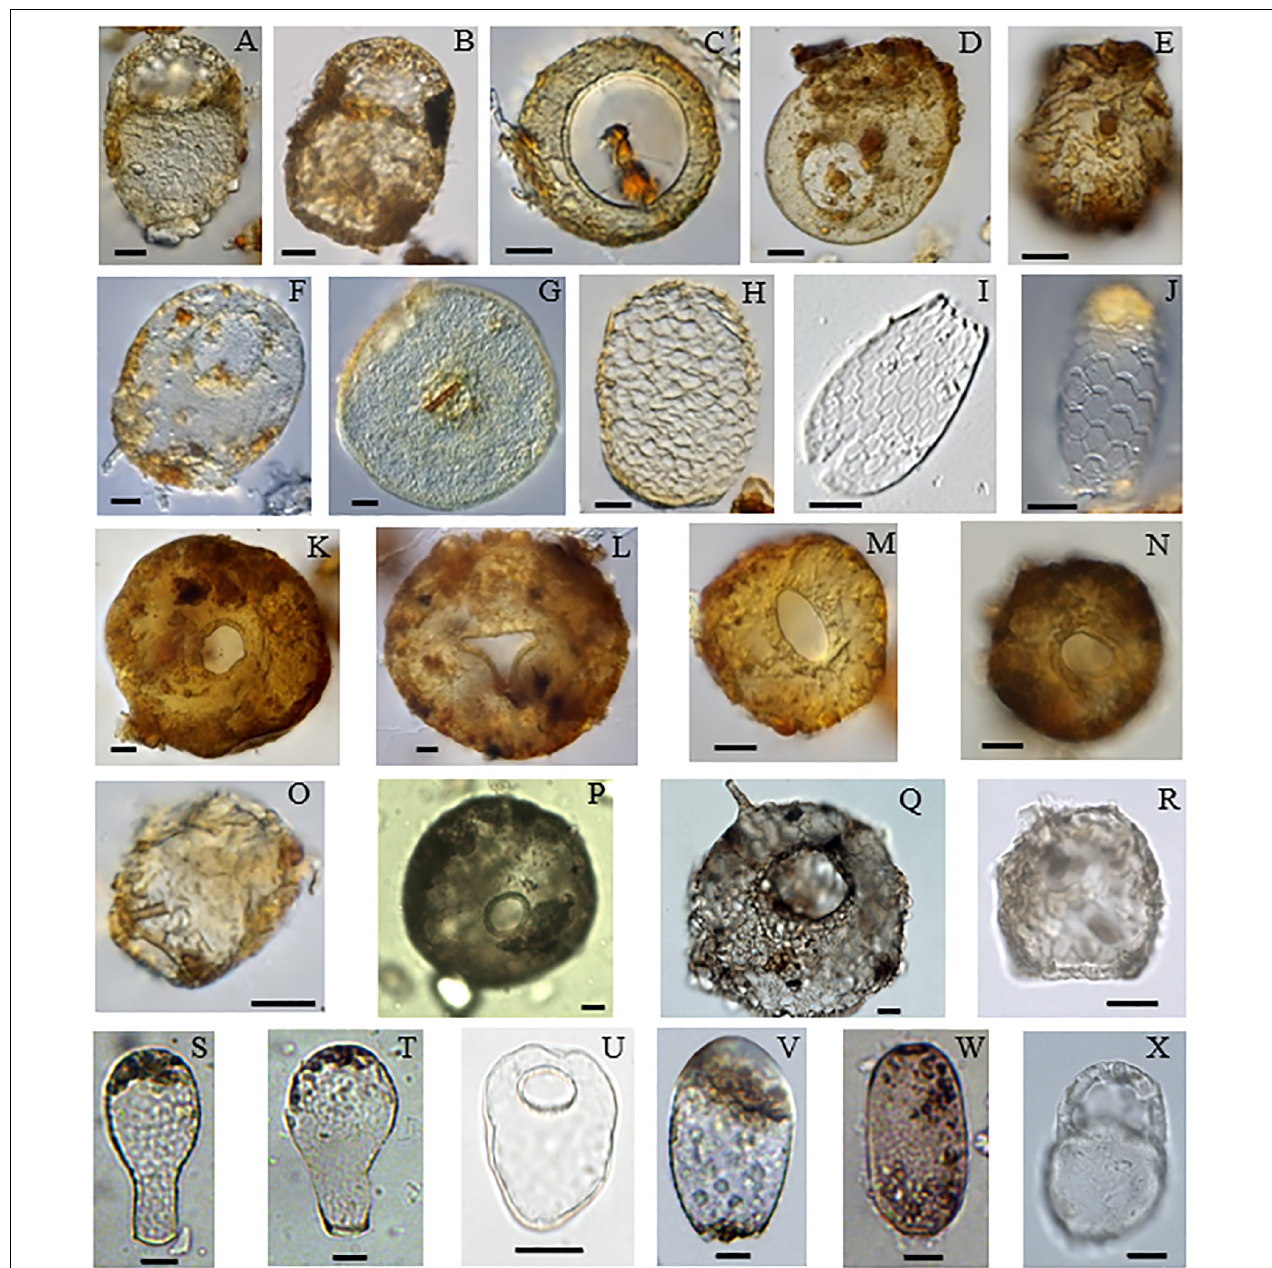
FIGURE 6 | Some taxa found in the samples. (A) Centropyxis constricta , (B) Centropyxis aerophila morph 1, (C) cf. Cyclopyxis eurystoma v. parvula morph 2, (D) Centropyxis aculeata oblonga morph 2, (E) Difflugia penardi morph 1, (F) Centropyxis aculeata oblonga morph 1, (G) Arcella arenaria v. compressa , (H) Heleopera sylvatica , (I) Euglypha rotunda , (J) Tracheleuglypha dentata morph 2, (K) Trigonopyxis sp1 morph 3, (L) Trigonopyxis arcula v. major , (M) Cyclopyxis sp1 morph 1, (N) Cyclopyxis sp1 morph 2, (O) cf. Cyclopyxis eurystoma f. alta , (P) cf. Trigonopyxis microstoma morph 1, (Q) Centropyxis aculeata morph 2, (R) Difflugia angulostoma , (S) Padaungiella tubulata morph 1, (T) Padaungiella wailesi morph 1, (U) Trinema complanatum morph 2, (V) Jungia sundanensis cf. ovoidalis , (W) Archerella flavum , and (X) Centropyxis platistoma morph 2. For taxa details, see Supplementary Table 2 . Scale bares = 10 µ m. Image A-O by F. Siemensma, P-X by A.S.